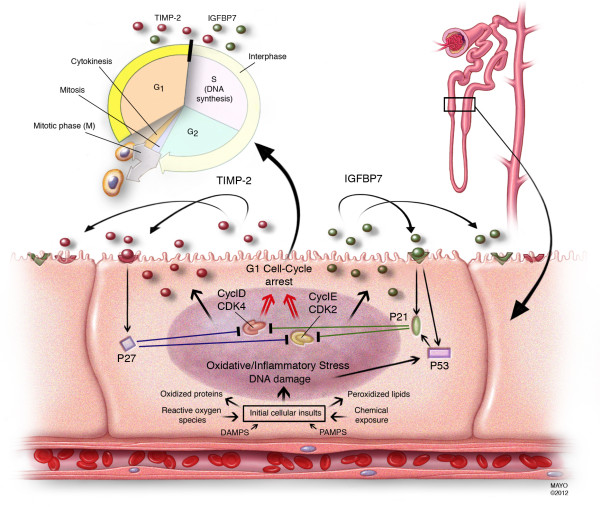
Proposed mechanistic involvement of the novel biomarkers in AKI: initial tubular cells sustain injury by various insults. In response to DNA and possibly other forms of damage, IGFBP7 and TIMP-2 are expressed in the tubular cells. IGFBP7 directly increases the expression of p53 and p21 and TIMP-2 stimulates p27 expression. These effects are conducted in an autocrine and paracrine manner via IGFBP7 and TIMP-2 receptors. The p proteins in turn, block the effect of the cyclin-dependent protein kinase complexes (CyclD-CDK4 and CyclE-CDK2) on the cell cycle promotion, thereby resulting in G1 cell cycle arrest for short periods of time presumably to avoid cells with possible damage from dividing. AKI, acute kidney injury; IGFBP7, insulin-like growth factor-binding protein 7; TIMP-2, tissue inhibitor of metalloproteinases-2.